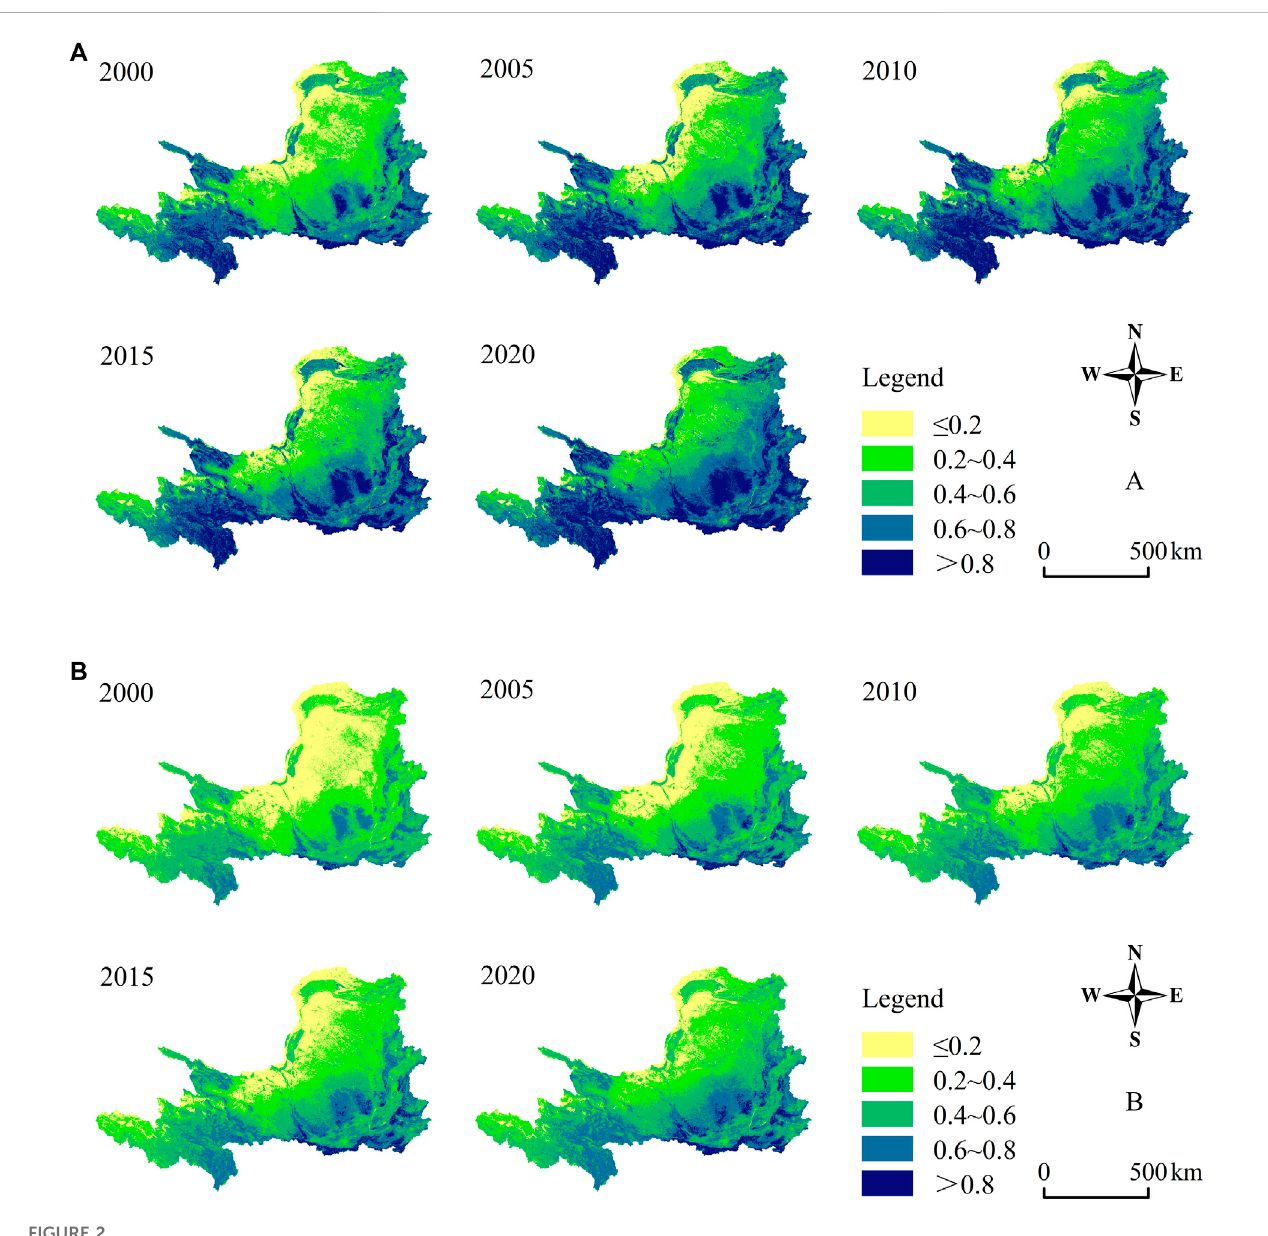
FIGURE 2 Spatial distributions of the (A) annual and (B) growing season NDVI.